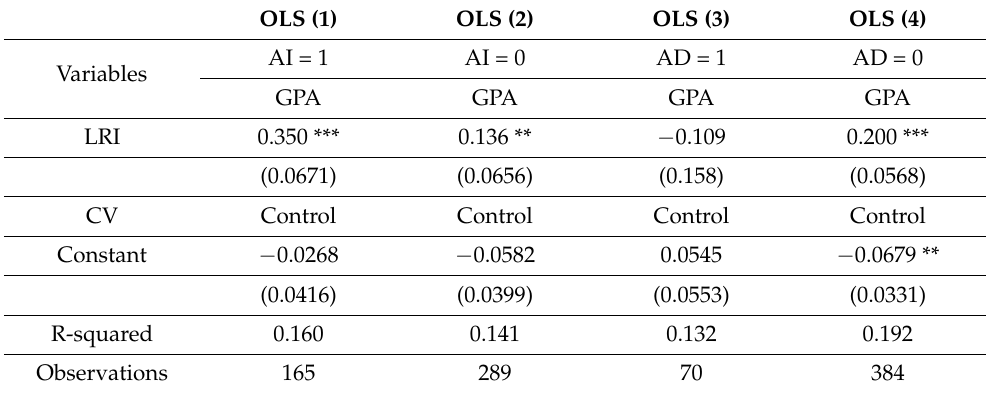
Table 7. Results of heterogeneity analysis of the effect of LRI on GPA: AI and AD. OLS (1) OLS (2) OLS (3) OLS (4) AI = Variables